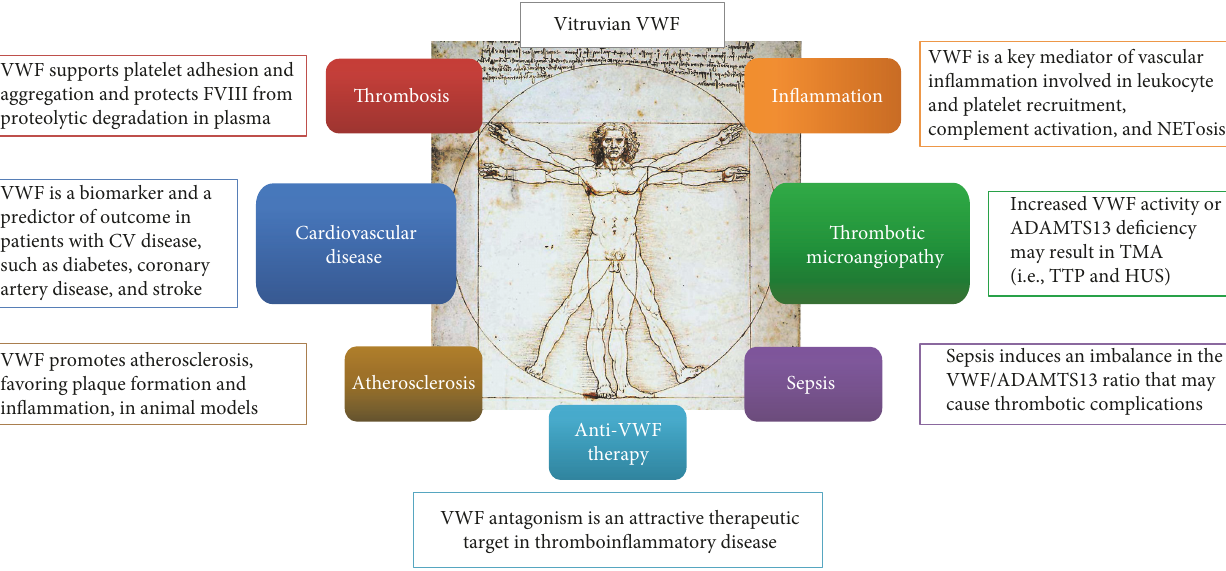
Figure 1: Functional heterogeneity of von Willebrand factor (VWF). VWF is best known for its role in hemostasis and thrombosis, supporting platelet adhesion/aggregation and protecting FVIII from proteolytic degradation in blood fl ow. However, it is now clear that VWF functions extend much further than that. VWF plays a key role in vascular in fl ammation, favoring leukocyte recruitment